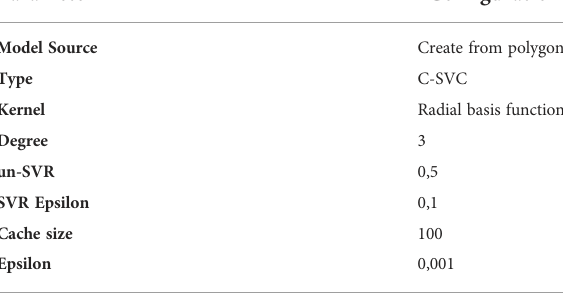
TABLE 2 Classi fi cation parameters for SVM algorithm computation in SAGA GIS